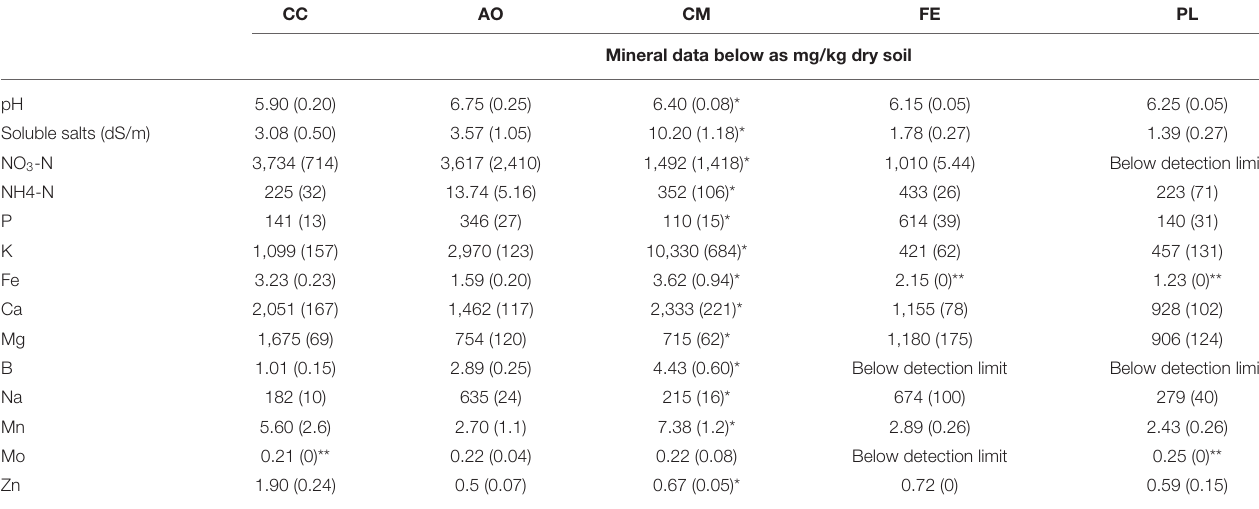
TABLE 2 | Soil nutrient profile comparisons for five fertility treatments